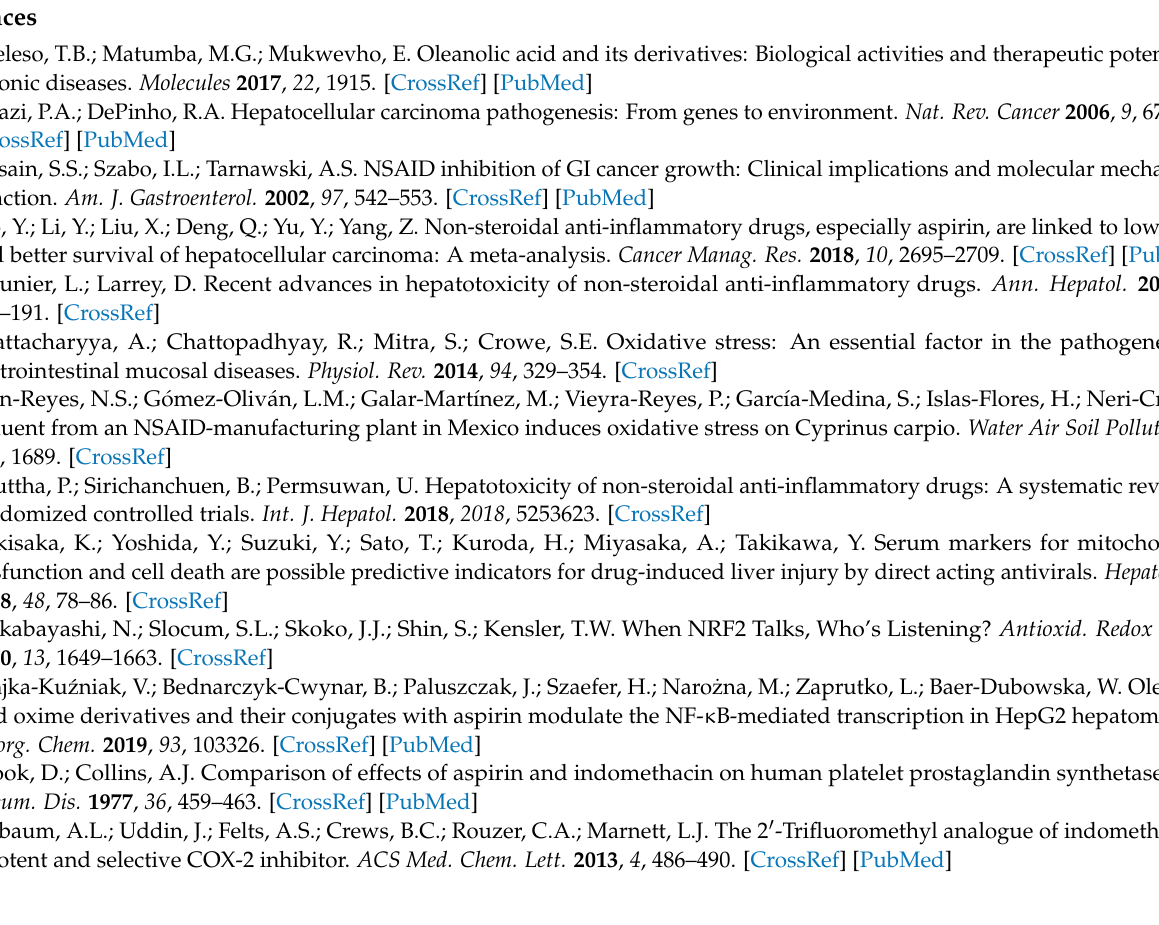
Figure S3: 1 H NMR for compound 3b , Figure S4: 13 C NMR for compound 3b , Figure S5: 1 H NMR for compound 3c , Figure S6: 13 C NMR for compound 3c , Figure S7: 1 H NMR for compound 3d , Figure S8: 13 C NMR for compound 3d